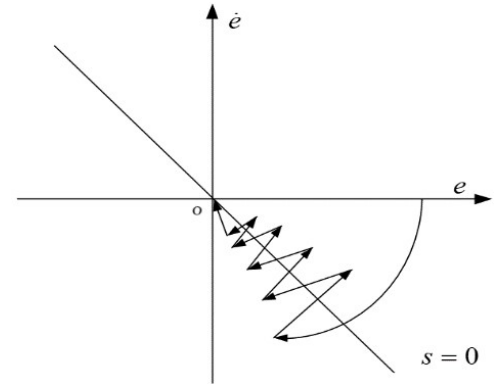
Figure 5. In-plane sliding mode state point movement.